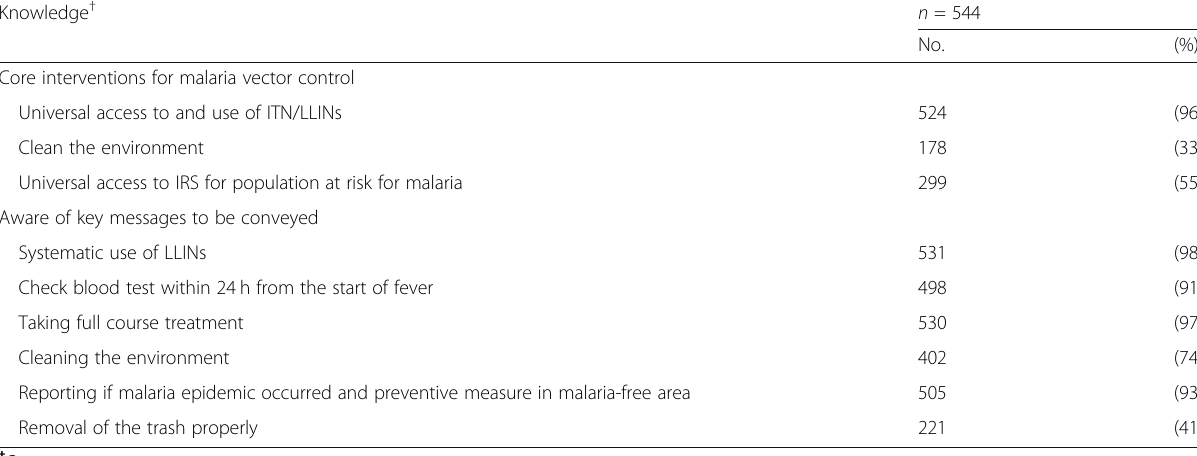
Table 3 Knowledge about vector control interventions and awareness of key malaria messages at six targeted townships for malaria elimination, Myanmar, 2017 to